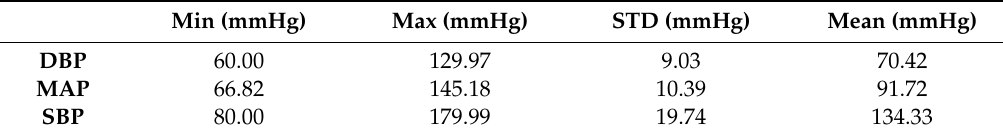
Table 2. Statistics of the blood pressure for the database used in the